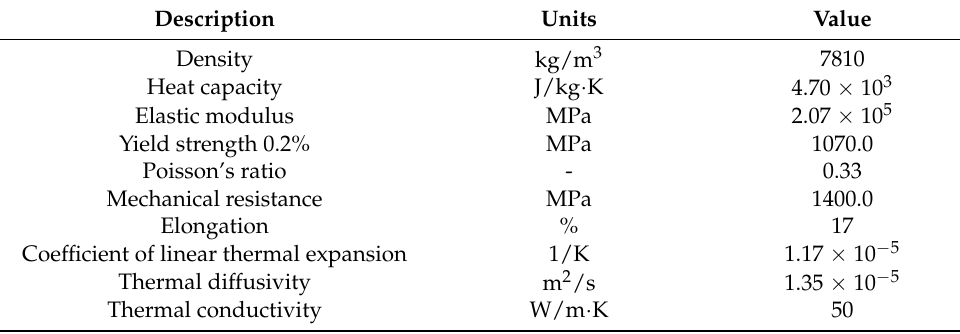
Table 4. Thermal, physical, and mechanical properties of Fastcool-50 at 44 HRC.